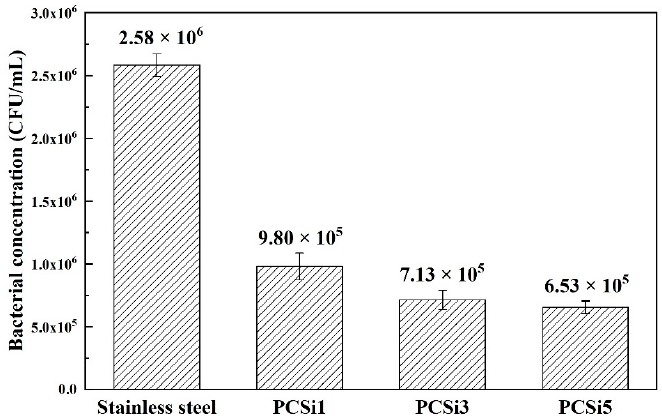
Figure 9. Plate counting statistics of samples after the antifouling test (error bar).